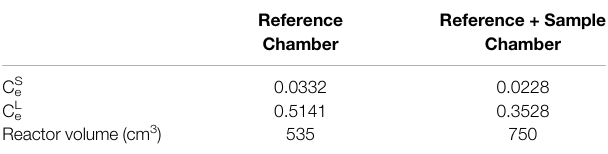
TABLE 1 | Parameters for the all-Pyrex two-aperture Knudsen fl ow reactor used from 1991 to 1993 displayed in Figure 3A .